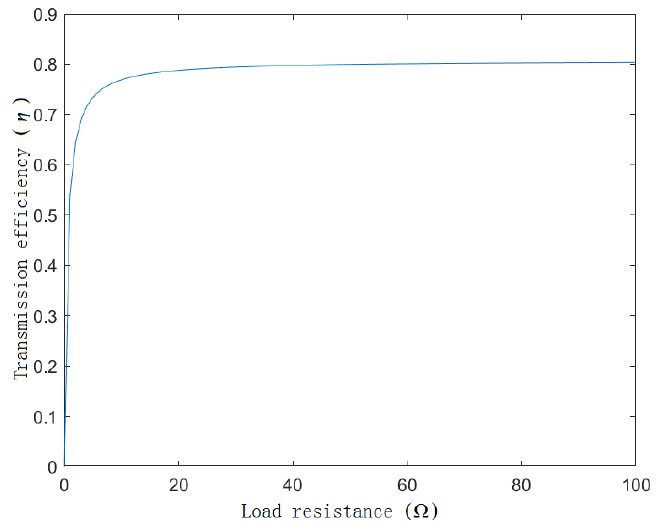
Figure 13. Relationship between transmission efficiency and load resistance under the three coils.